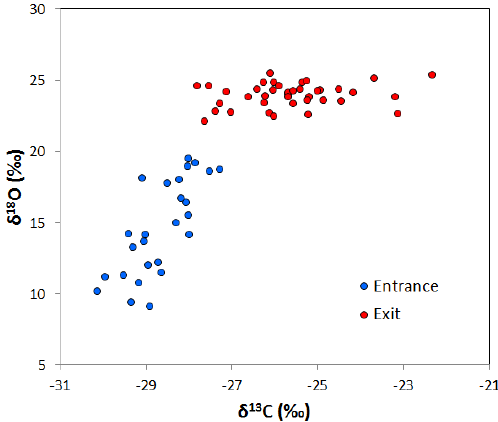
18 O V-PDB (‰) vs. δ V-SMOW (‰) plot of Islisberg highway tunnel samples. Data from Popa et al. (2014). The δ values of the samples collected at the entrance and exit are depicted by blue and red markers,